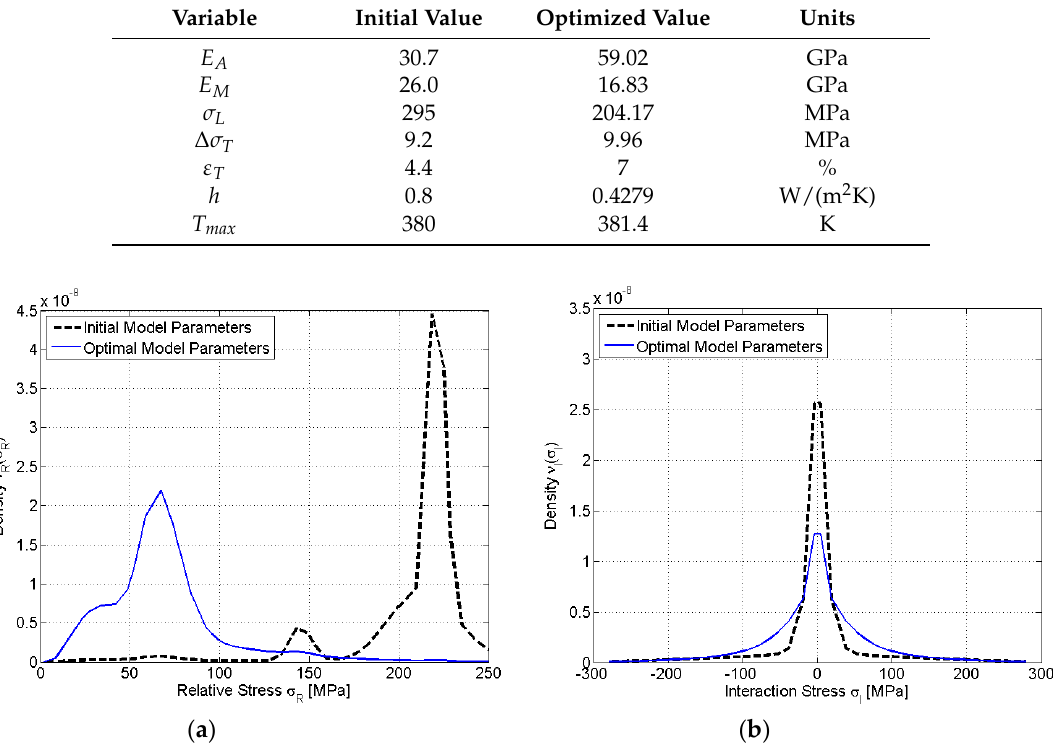
Figure 13. Comparison between initial and optimized ( a ) relative stress density and ( b ) interaction stress density.